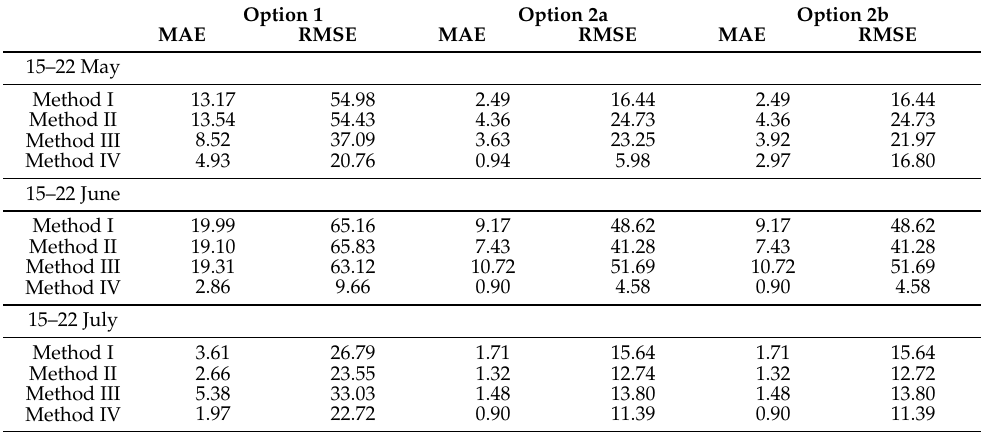
Table A1. Error metric for baselines in the middle weeks of May, June and July, 2019. Units in [W].